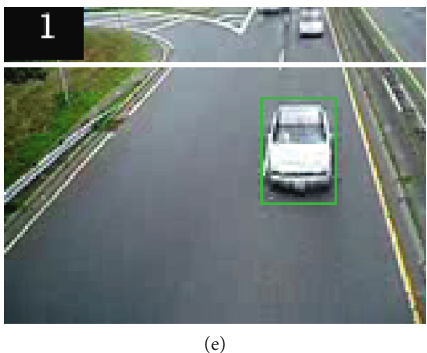
Figure 6: Detection results of the traditional optical flow method. (a) The original image. (b) Grayscale image. (c) Optical flow vector. (d) Morphological filtering. (e) Test results.